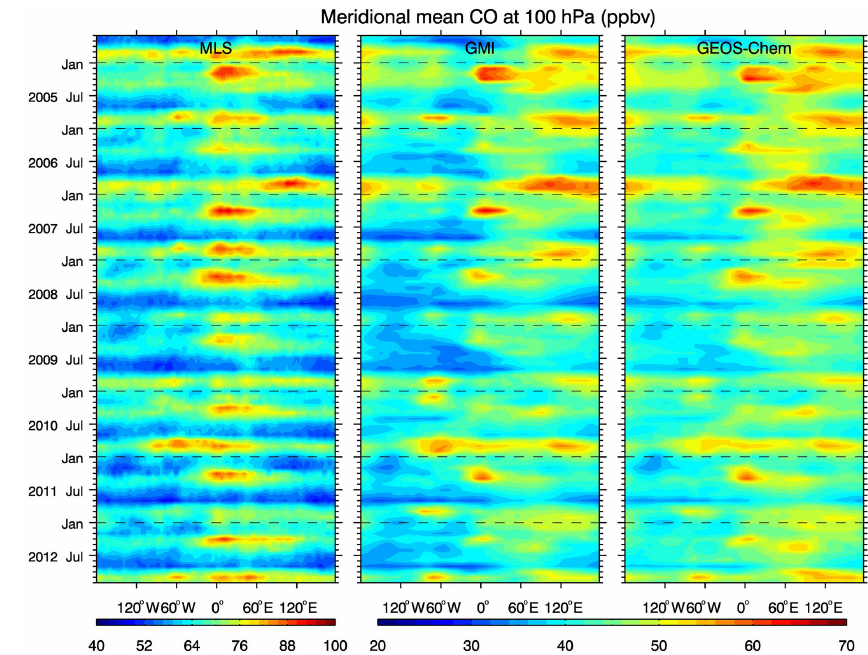
Figure 8. As in Fig. 7, but for CO mixing ratio at 100hPa.